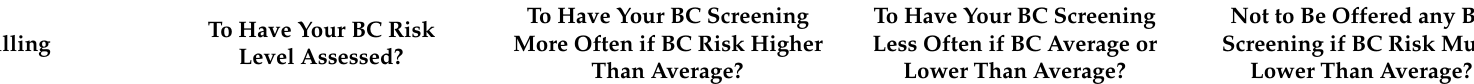
Table 4. Mutually adjusted logistic regression models for the associations between willingness to have breast cancer risk assessment and to modify breast screening and participants’ characteristics ( n =